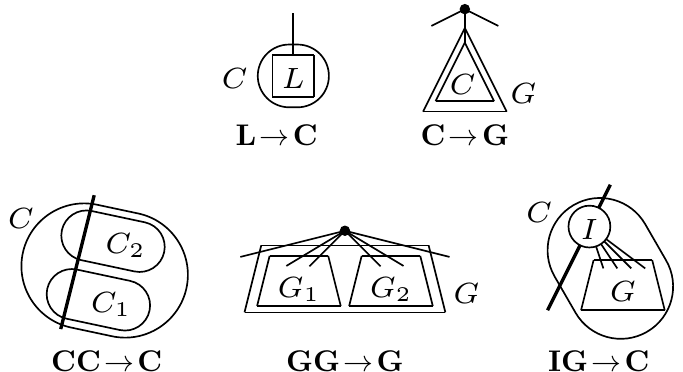
Figure 11. The two types of transformations ( top ) and the three types of compositions ( bottom ).